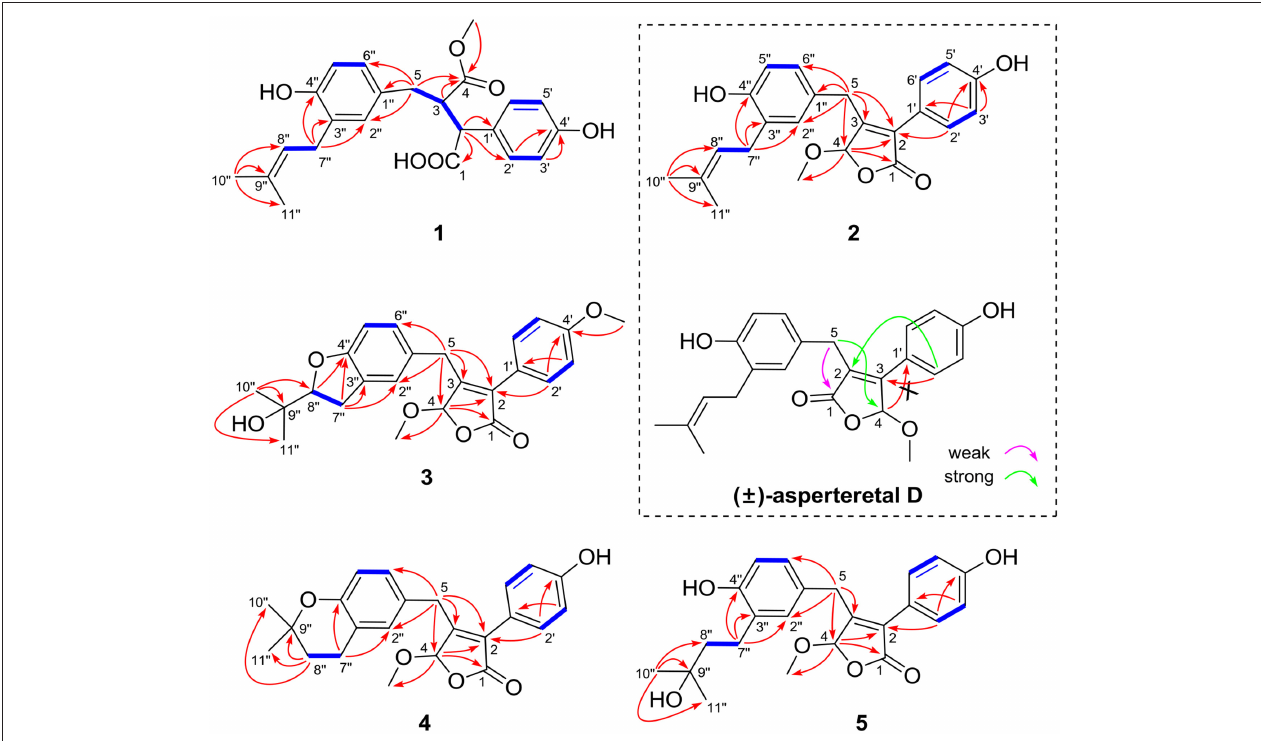
FIGURE 2 | Selected 1 H– 1 H COZY (blue bold lines) and HMBC (single arrows) correlations of compounds 1 – 5 and key HMBC analysis in original structure ( )-asperteretal ±